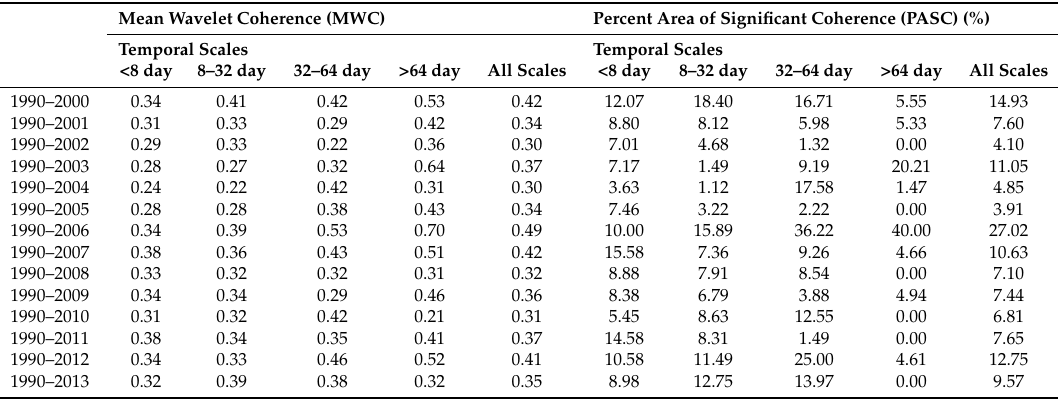
Table 1. Statistical results of wavelet coherence based on correlations and similarities of precipitation patterns in the target year, 1990, and reference years from 2000 to